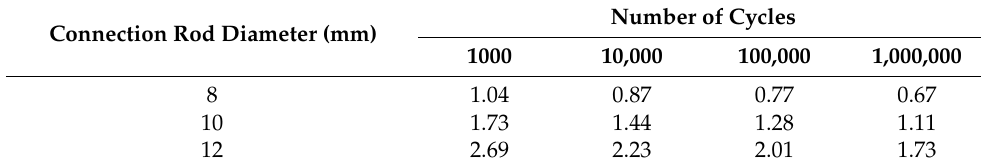
Table 5. Safety factors for various designs of the spike segment.